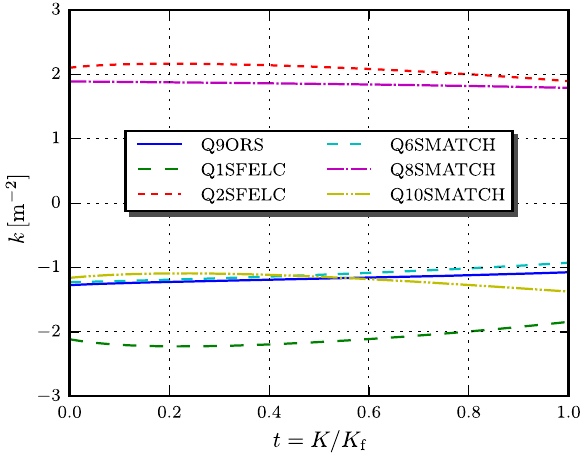
FIG. 5. Example of a correction function calculated using the presented method. Here, the strengths k of the six selected quadrupole magnets (see legend) are used as correction param- eters to compensate for the optics disturbance caused by the sFLASH undulator being closed from K ¼ 0 to a final value of K ¼ K 2 . 63 at a beam energy of 693 MeV. f ¼